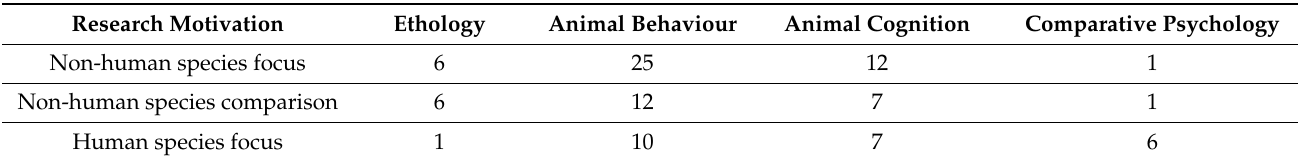
Table 1. Matrix with raw data relating the name of preference for the discipline and the underlying research motivation ( N =